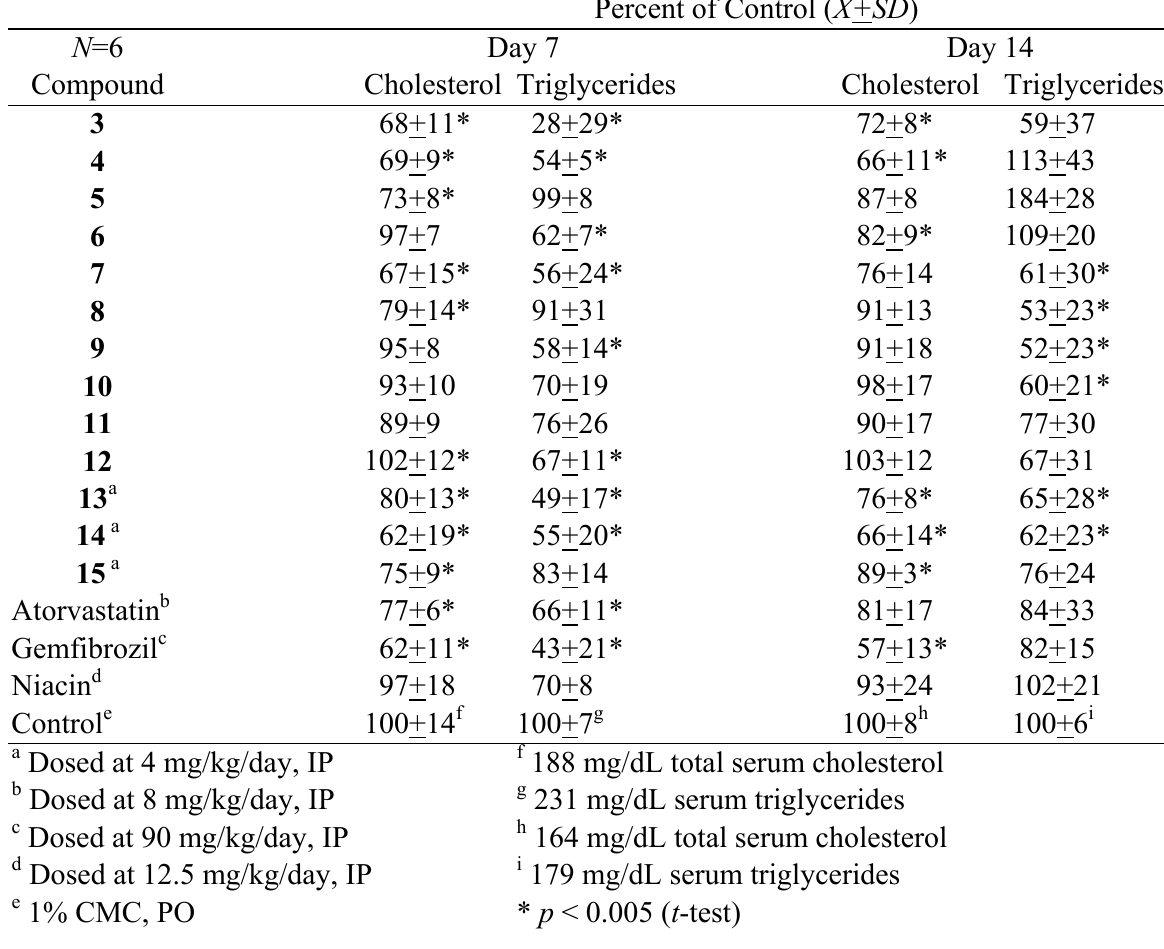
Table 4: In Vivo Hypolipidemic Activity of the substituted pyrroles ( 3-15 ) in CF-1 male mice at 8mg/kg/day, IP for 14